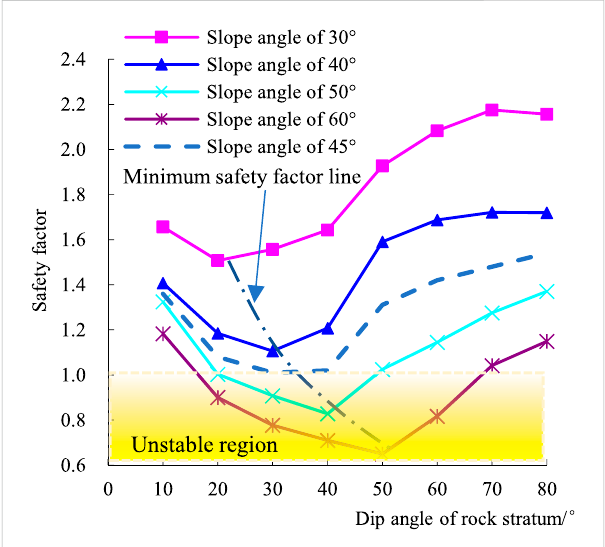
FIGURE 10 In fl uence of internal friction angle of weak interlayer on safety factor at different interlayer dip angle.